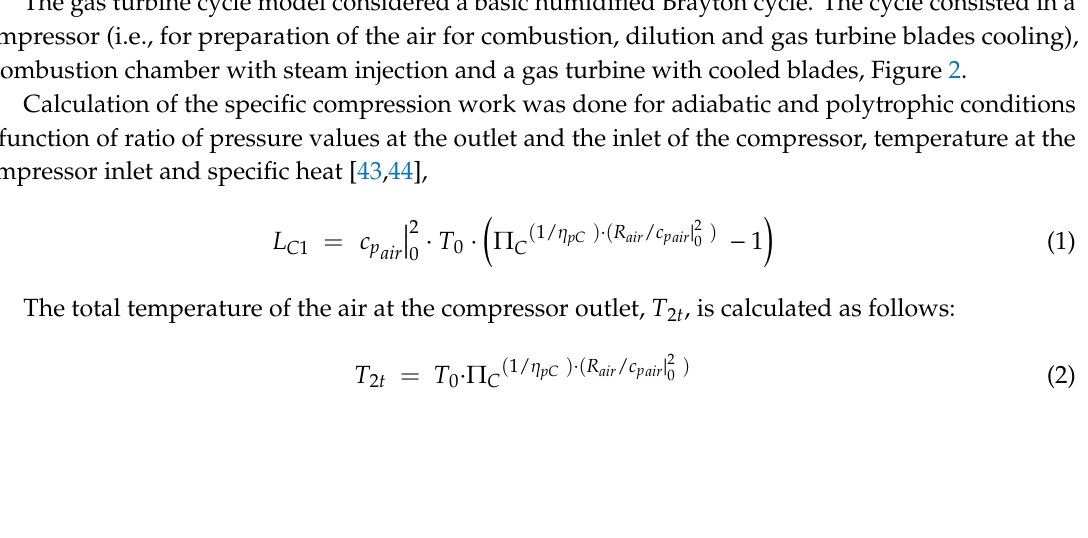
Figure 2. Basic humidified Brayton cycle with cooling air extraction at the compressor exhaust (where C is compressor, CC combustion chamber and T is gas turbine, point 0 refers to ambient conditions, point 1—conditions at the compressor inlet, point 2—conditions at the compressor outlet or combustion chamber inlet, point 3—combustion chamber outlet or gas turbine inlet, point 4—gas turbine outlet).